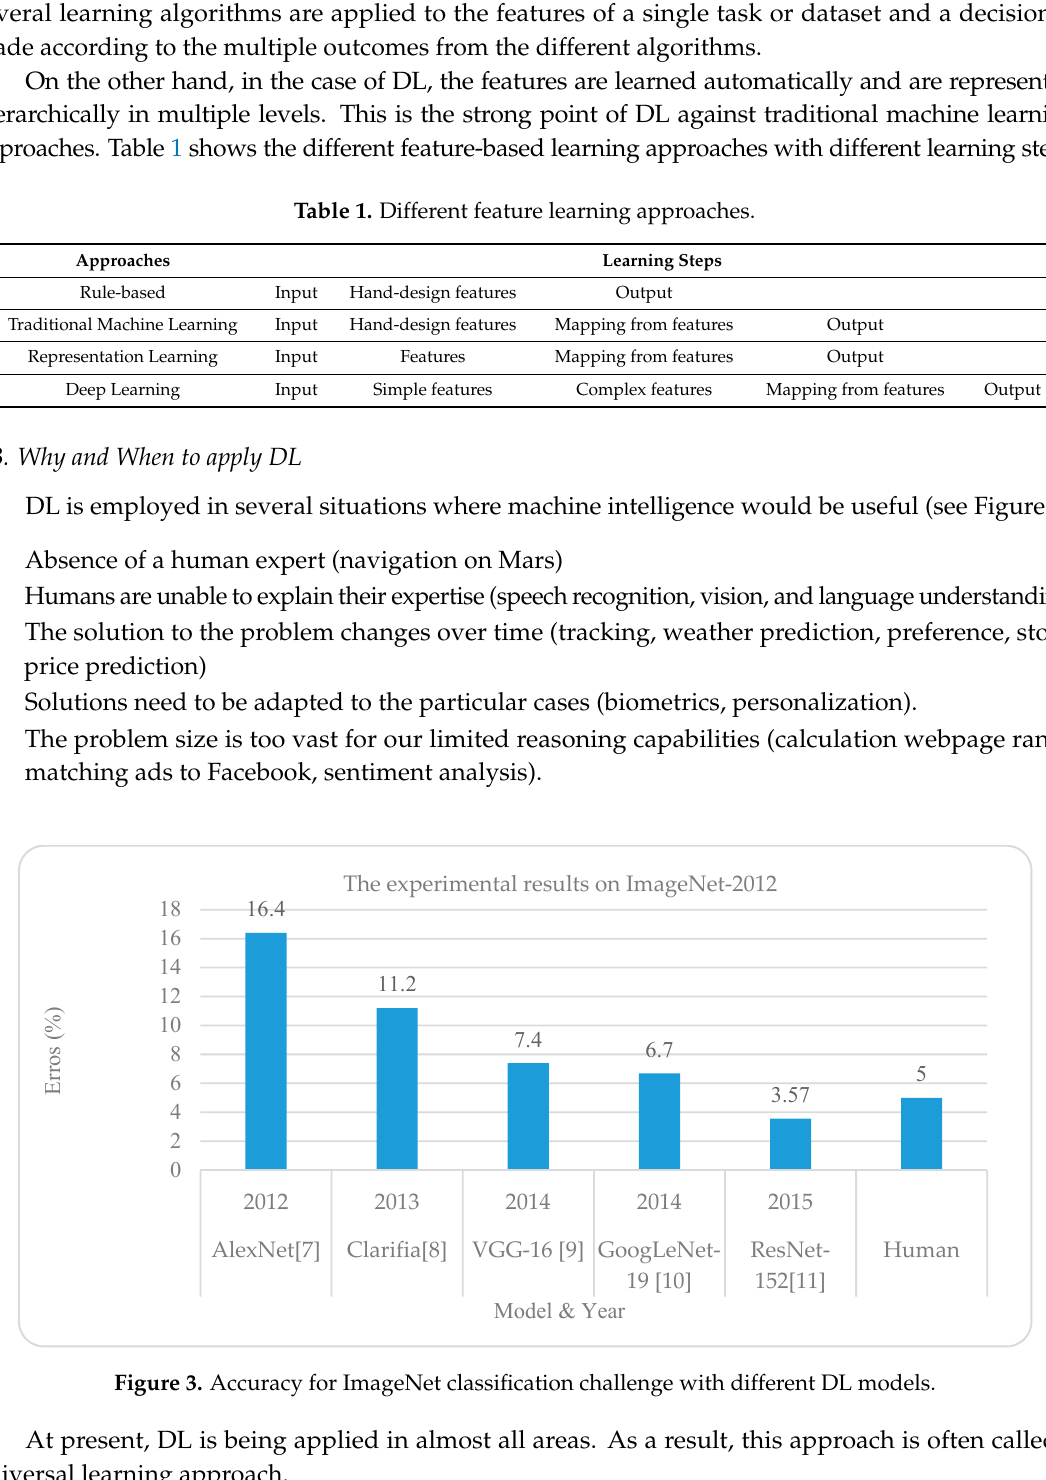
Figure 4. Phone error rate (PER) for TIMIT Acoustic-Phonetic Continuous Speech Corpus dataset [13– 23]. (b). Automatic speech recognition . The initial success in the field of speech recognition on the popular TIMIT dataset (common data set are generally used for evaluation) was with small-scale recognition tasks [24]. The TIMIT Acoustic-Phonetic continuous speech Corpus contains 630 speakers from eight major dialects of American English, where each speaker reads 10 sentences. Figure 4 summarizes the error rates, including these early results and is measured as a percent phone error rate (PER) over the last 20 years. The bar graph clearly shows that the recently developed DL